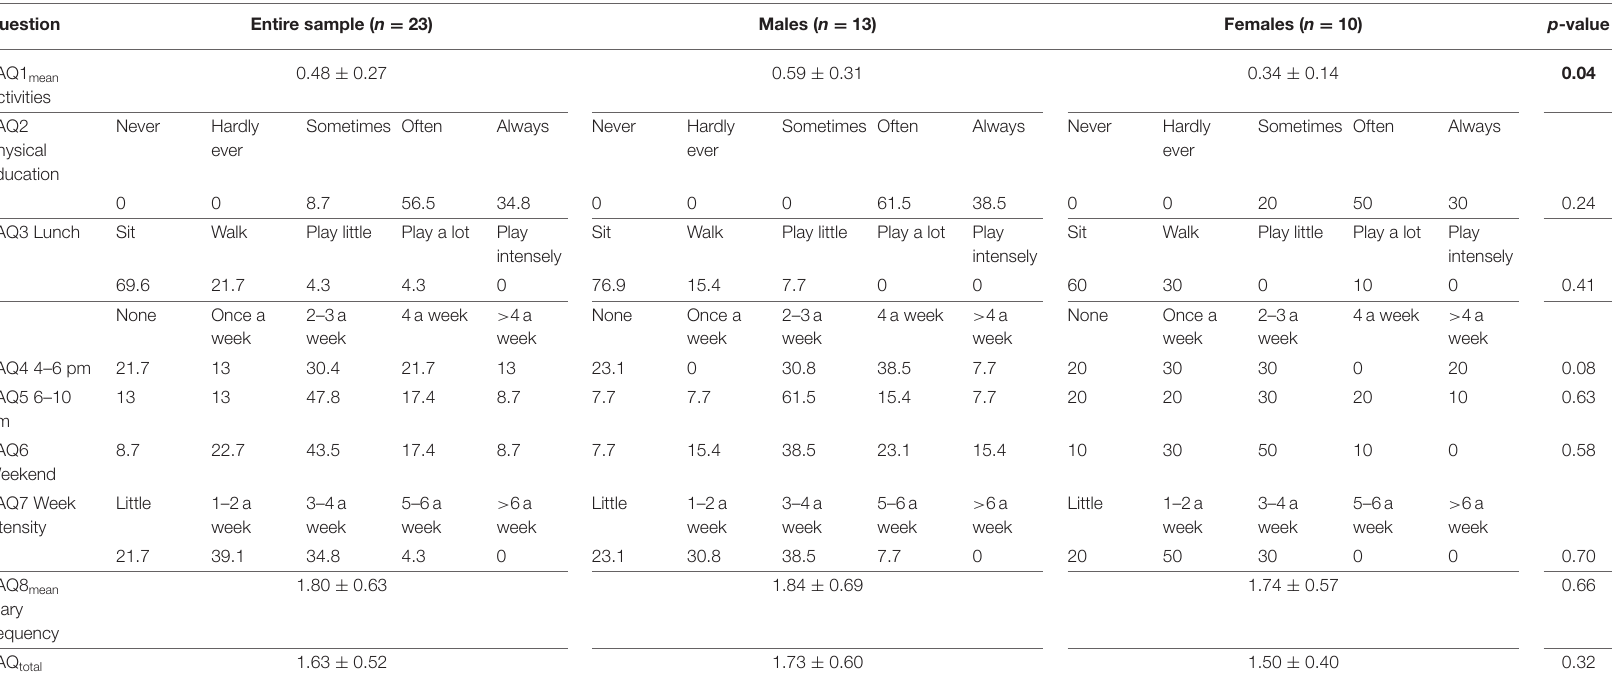
TABLE 2 | Comparisons in Physical Activity Questionnaire for Adolescents (PAQ-A) results between elite, male and female, under 14 basketball players. Question Entire sample ( n = 23) Males ( n = 13) Females ( n = 10) p -value PAQ1 mean